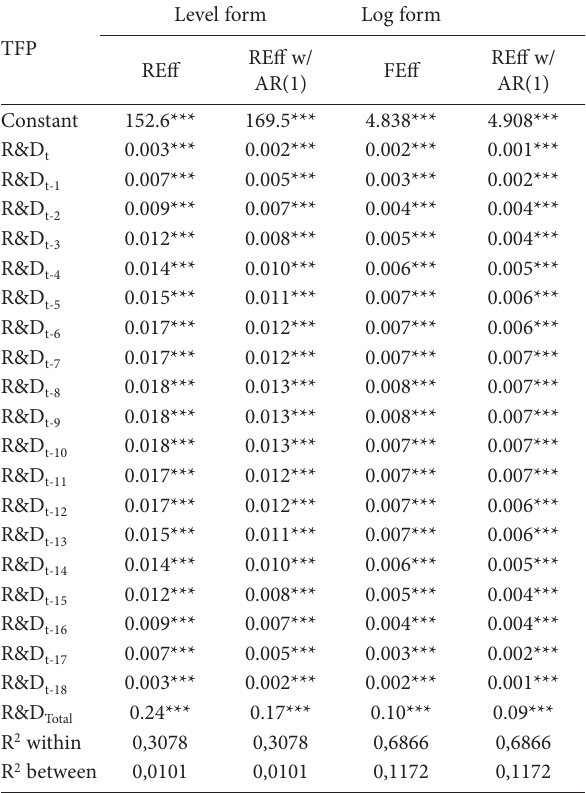
Table 3. Results from TFP